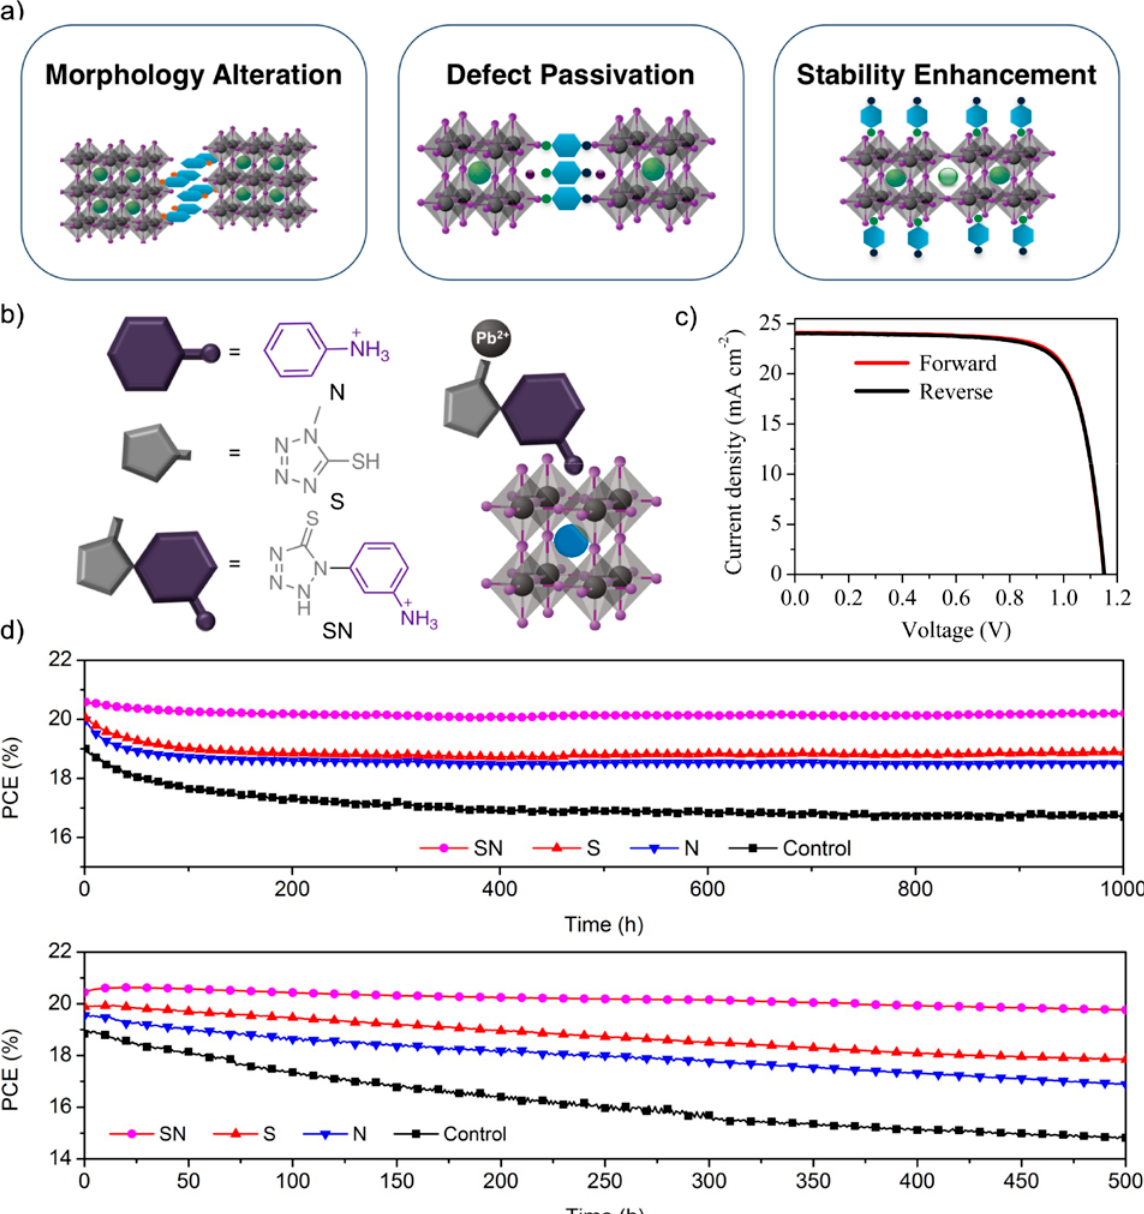
Figure 9. Molecular modulation case. (a) Overview of effects of molecular modulation on hybrid perovskite solar cells: morphology altera- tion, defect passivation, and stability enhancement. Adopted with permission from ref. 51 (b) Example of molecular modulators N (purple), S (grey), and SN (purple-grey) with a schematic representation of the interaction of SN with Pb 2+ ions (grey sphere) and the hybrid perovskite (FAPbI 3 ). (c) J-V curves of the modulated champion device recorded in reverse (black; from V OC to J SC ) and forward (red; from J SC to V OC ) scanning directions under AM 1.5G solar radiation. (d) Evolution of power conversion efficiency of devices over time upon continuous light illumination at 65 °C and maximum power point tracking under argon (upper) and ambient air (lower) conditions. Adapted from ref.